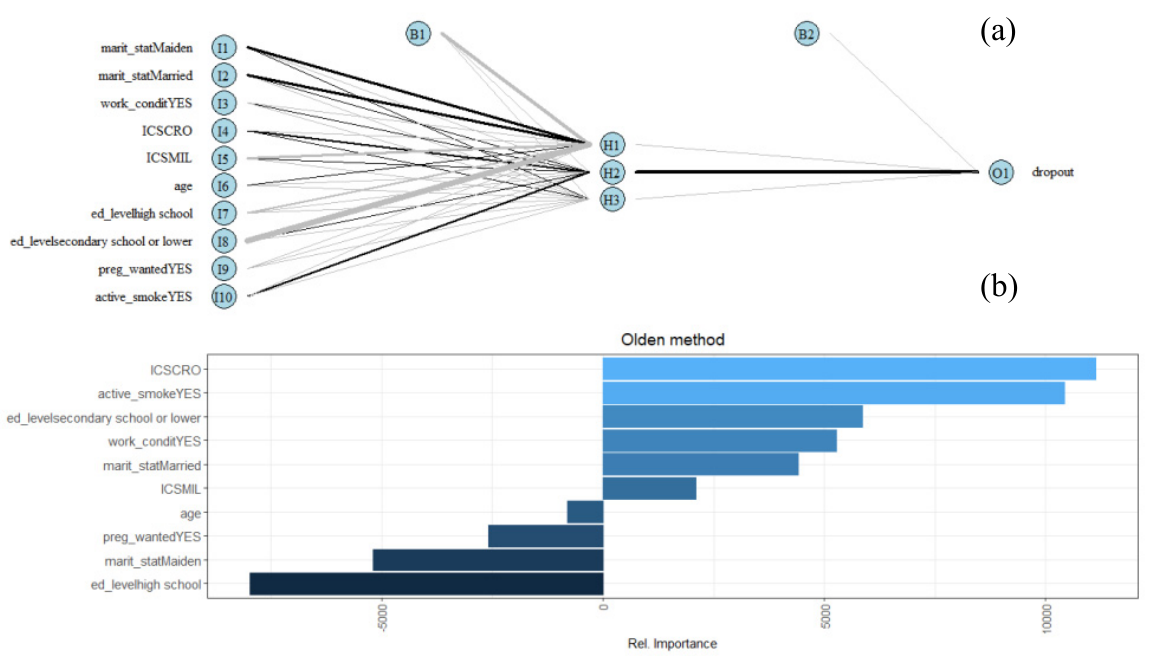
Figure 5. Neural network classifier analysis including the following input variables: Industrially Contaminated Site (ICS), age, educational level, marital status (never married, married, separated/divorced), working condition, active smoking, and pregnancy wanted. ( a ) The neural network plot with 10 input nodes, a three-node hidden layer, and the output node; ( b ) importance of the variables in the estimated model.